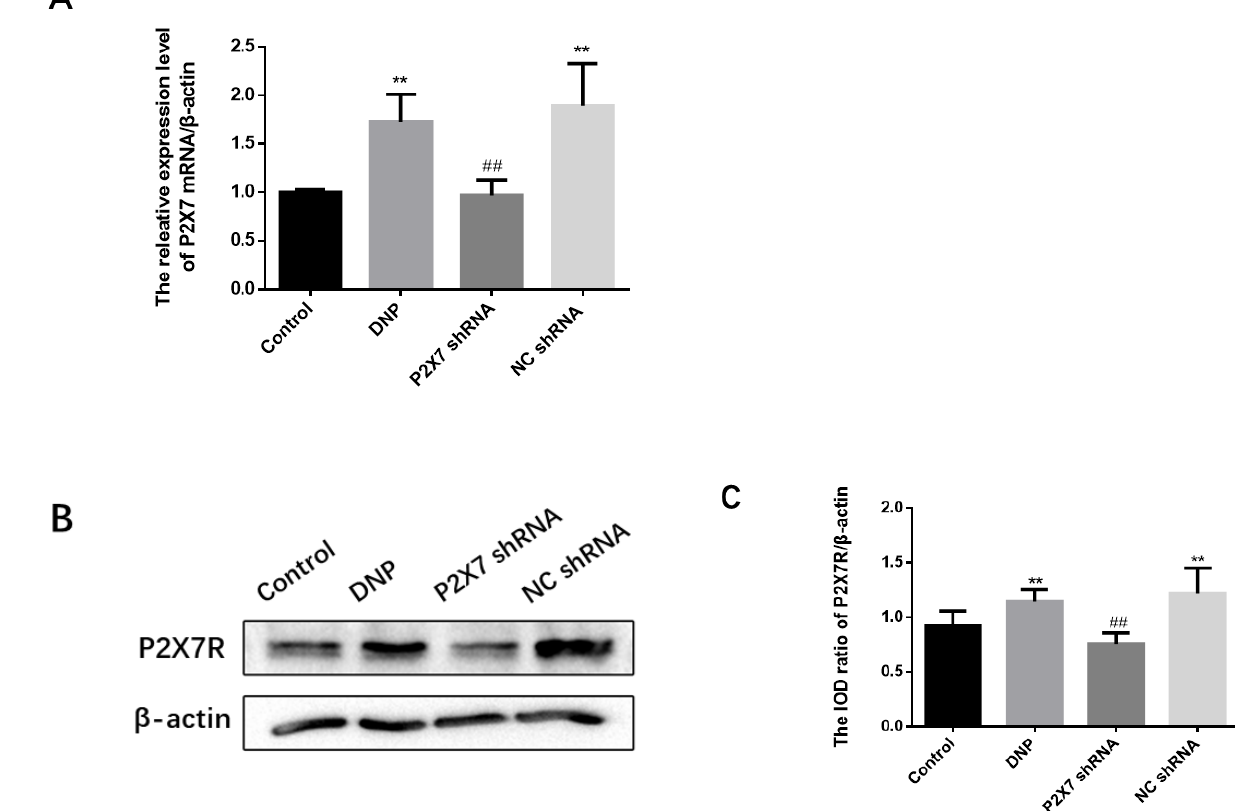
Figure 4. Measurement of P2X7 mRNA and protein levels in the DRG and co-expression levels of P2X7R with GFAP. ( A ) P2X7 mRNA. ( B ) SDS-PAGE of P2X7R protein in DRG of experimental rats in each group. ( C ) P2X7R protein expression in the DRG of each group was analyzed. ( D ) Co- expression of GFAP and P2X7R in DRG. ( E ) Relative fluorescence intensity levels of GFAP in each group. ( F ) Relative fluorescence intensity levels of GFAP and P2X7R co-expression. P2X7 mRNA, protein levels, and co-expression levels of P2X7R and GFAP in the P2X7 shRNA group were lower than in the DNP rats. Blue staining (DAPI) marks the nucleus, green staining (GFAP) marks activated SGCs, and red staining marks P2X7R. The scale bar represents 50 µm; data are shown as mean ± SEM based on at least three independent experiments, n = 6; ** p < 0.01 versus the Control group; ## p < 0.01 versus the DNP group. The co-expression of P2X7R with GFAP, an SGC marker, was examined using immunofluorescence double-labeling (Figure 4D). Activated satellite glia have been linked to pain [8]. We quantified the expression of GFAP in each group (Figure 4E). The